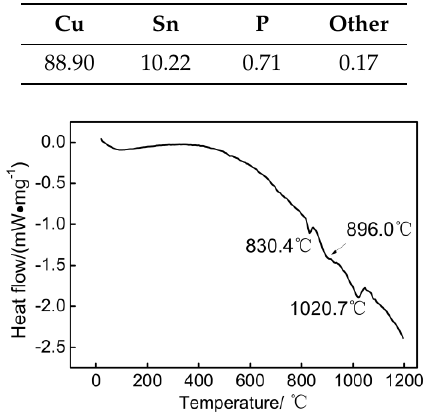
Table 1. Chemical composition of ZCuSn10P1 alloy (mass %).